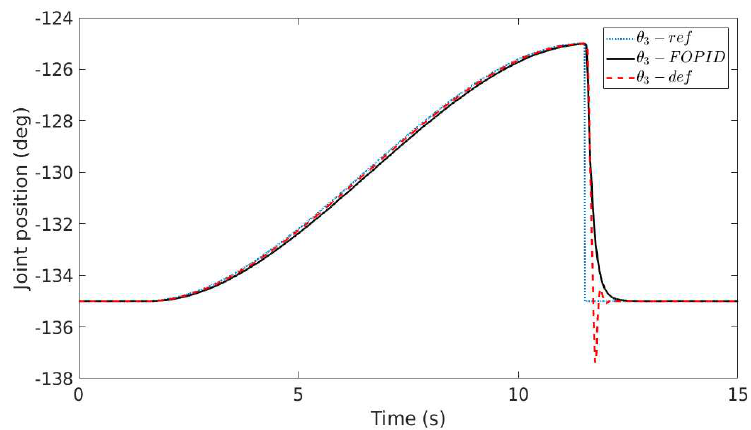
Figure 7. Step response of the UR10 robot for joint 3—the second robot configuration (ref = reference signal, FOPID = closed loop response with FO-PI controller in (23), def = default robot PID controller).